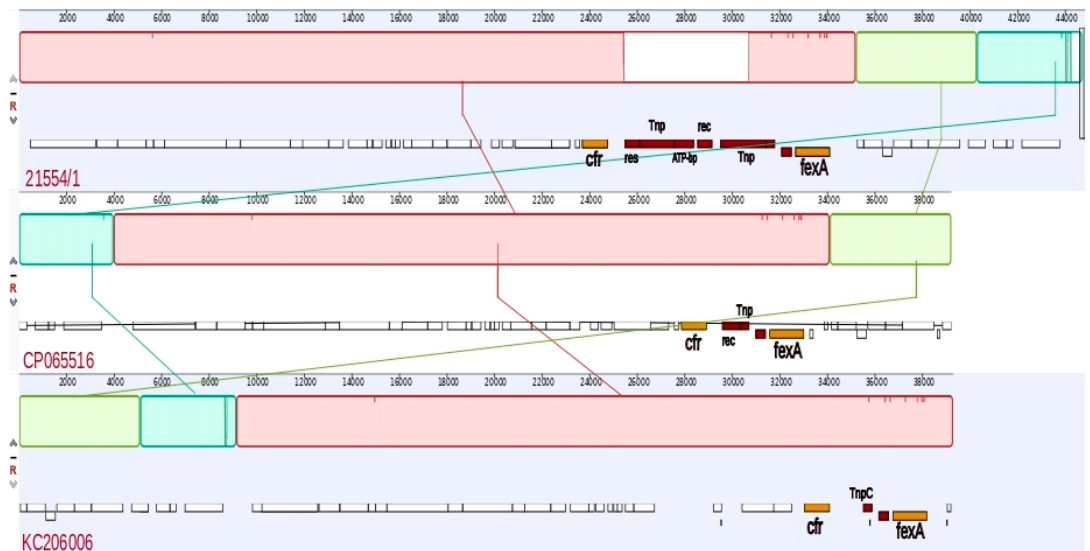
1575 non-coding RNA (ncRNA) sequence is in light green. The Tn558 composite transposon-like structure (~13,774 bp) is indicated in greenish-blue, and the origin of replication is in light blue.